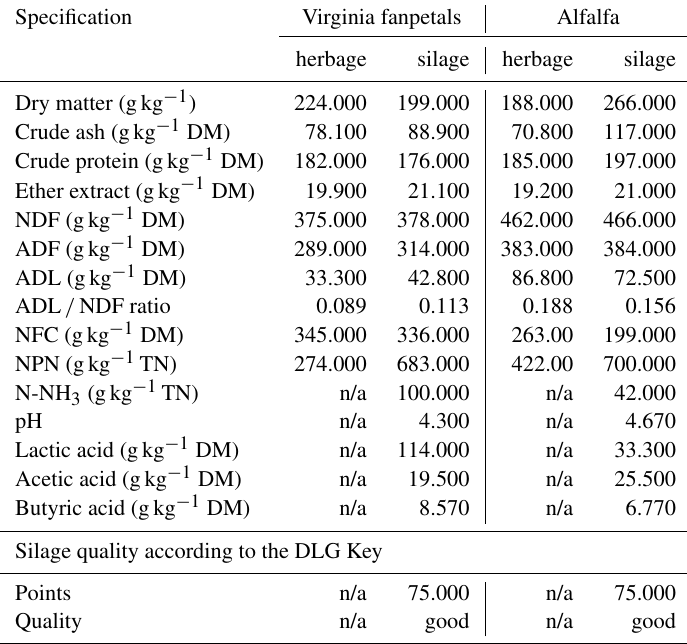
Table 1. Chemical composition and fermentation products (gkg − 1 of DM) of silage.